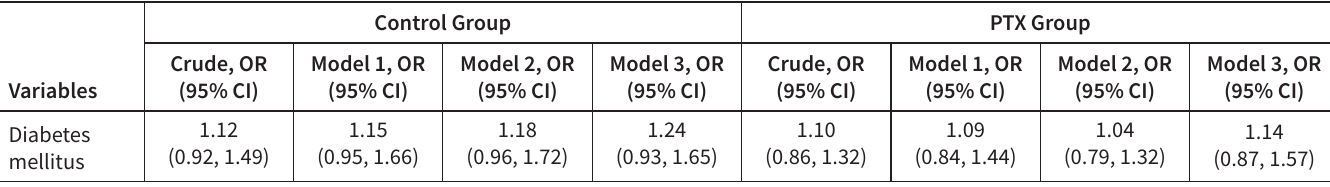
Table 3. The Univariate and Multiple Logistic Regression for Evaluation of Association Between CIN and Diabetes Mellitus by Adjusted Important